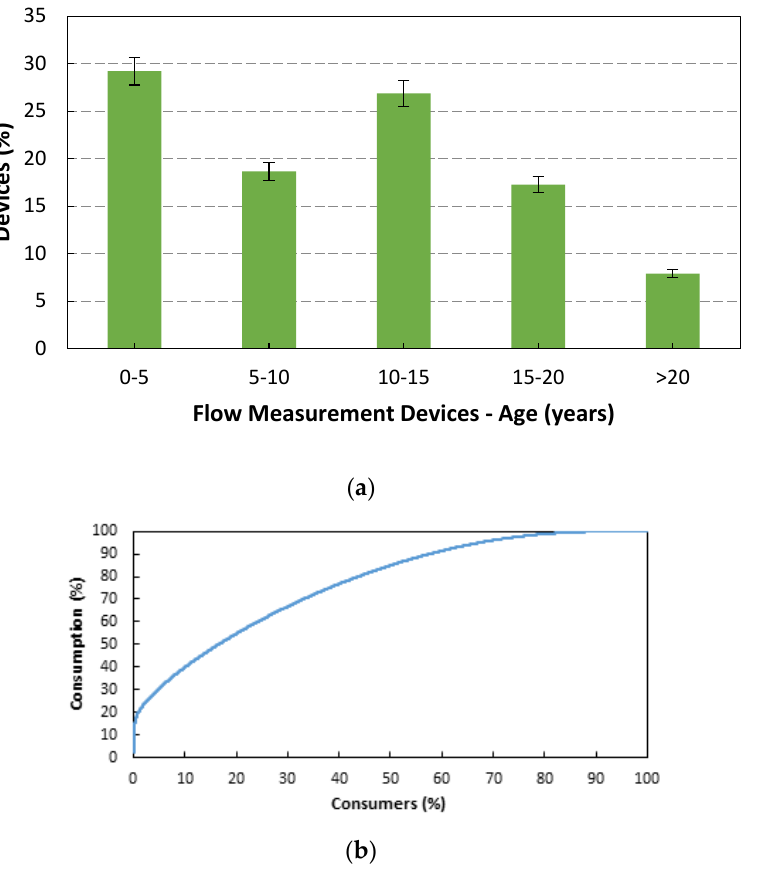
Figure 17. Identification of critical flow meters and consumers: ( a ) age distribution of municipal flow meters and ( b ) consumption/consumers percentage relation.